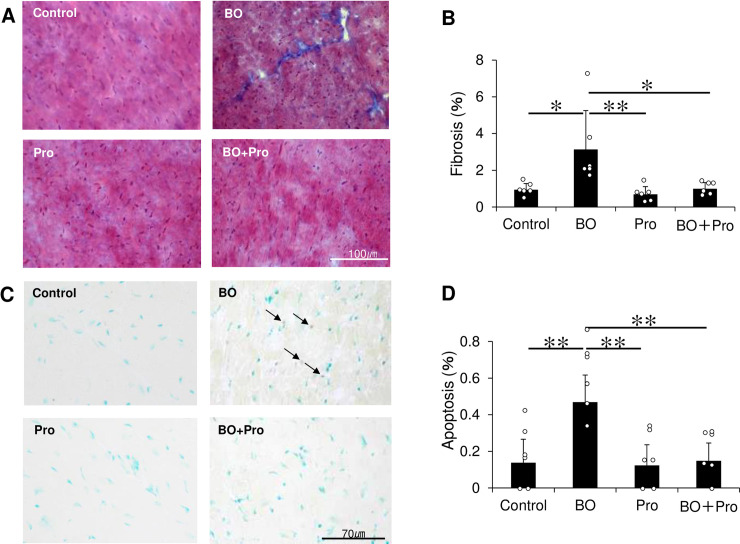
Effects of BO on fibrosis and apoptosis in the heart.(A) Representative images of Masson-trichrome-stained sections of cardiac muscle in the Control (upper left), BO (upper right), Pro (lower left) and BO + Pro (lower right) groups. (B) The area of fibrosis was significantly increased in the BO group, but this increase was blocked in the BO + Pro group. *P < 0.05 or **P < 0.01 by one-way repeated-measures ANOVA followed by the Tukey-Kramer post hoc test (S5A Fig of S1 Data). (C) TUNEL-positive nuclei (black arrows) in representative TUNEL-stained sections were counted in cardiac muscle in the Control (upper left), BO (upper right), Pro (lower left) and BO + Pro (lower right) groups. (D) The number of TUNEL-positive nuclei was significantly increased in the BO group, but this increase was blocked in the BO + Pro group. **P < 0.01 by one-way ANOVA followed by the Tukey-Kramer post hoc test (S5B Fig of S1 Data). Data show means ± SD and scattered dots show individual data.